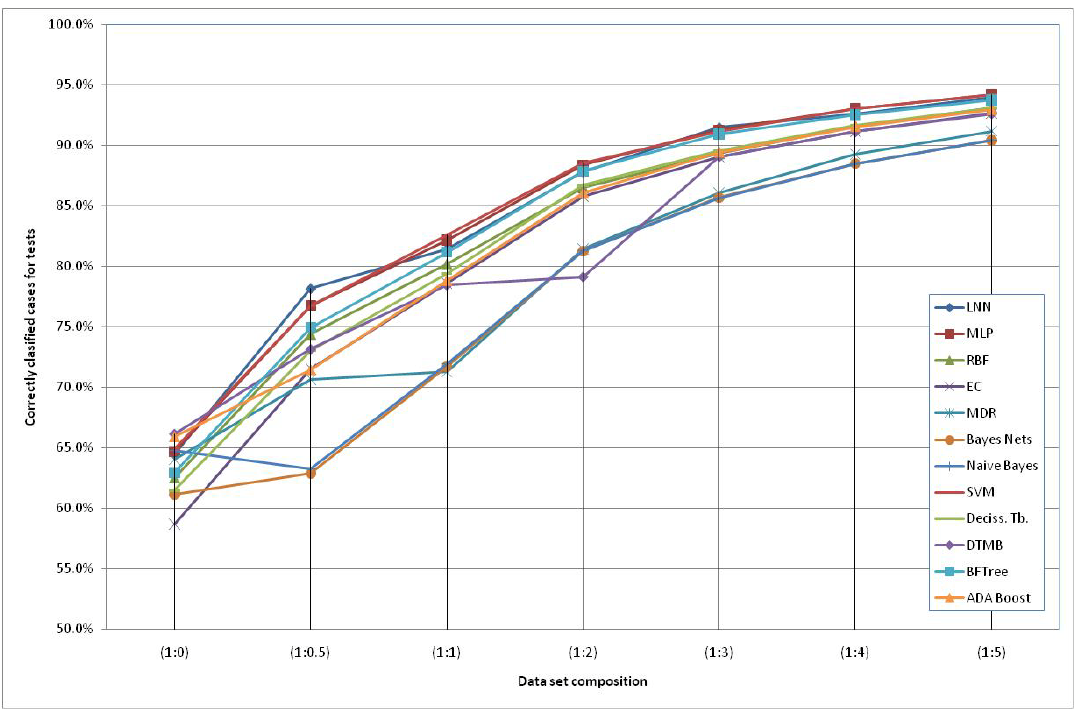
Figure 2. Correctly classified subjects depending on the simulated negative data for both genes; the dataset labels represent the proportion between real subjects (positive and negative = case and control) and simulated negative